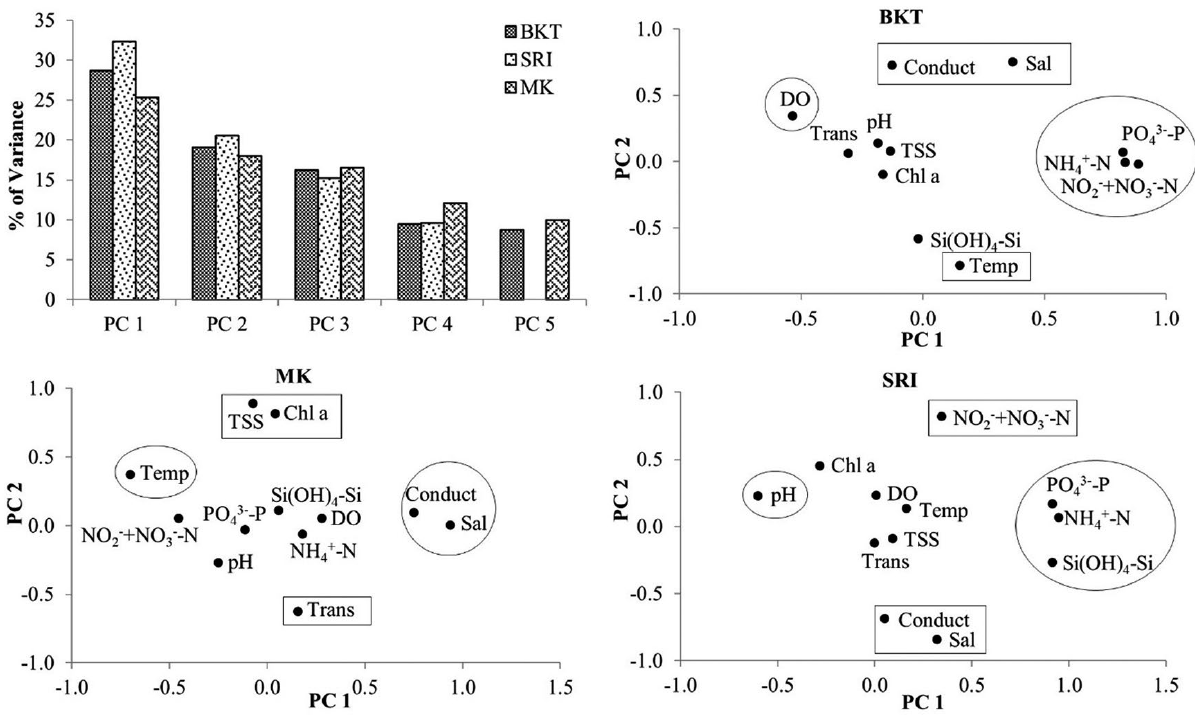
Fig. 6. – Bar chart and scatter plots showing the results of principal component analysis (significant factor of PC 1 [circle] and PC 2 [square]) for seawater variables [temperature (Temp), pH, salinity (Sal), conductivity (Conduct), dissolved oxygen (DO), transparency (Trans), total suspended solids (TSS), ammonium-nitrogen (NH 4+ -N), nitrite and nitrate-nitrogen (NO 2– +NO 3– -N), phosphate-phosphorus (PO 43– -P), silicate-silicon -Si), and chlorophyll a (Chl a )] at the three sampling sites [Bang Khun Tien (BKT), Maeklong river mouth (MK) and Sriracha (Si(OH) 4